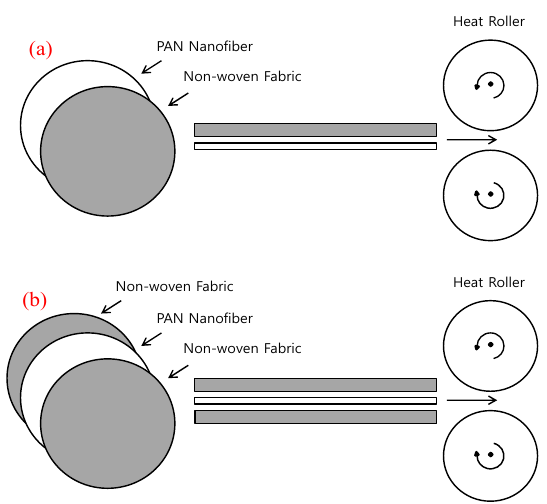
Figure 2. Process setup of the lamination of heat roller: ( a ) PAN (polyacrylonitrile) nanofiber, non-woven fabric (2-layers structure); and ( b ) non-woven fabric, PAN nanofiber, non-woven fabric (three layer structure).